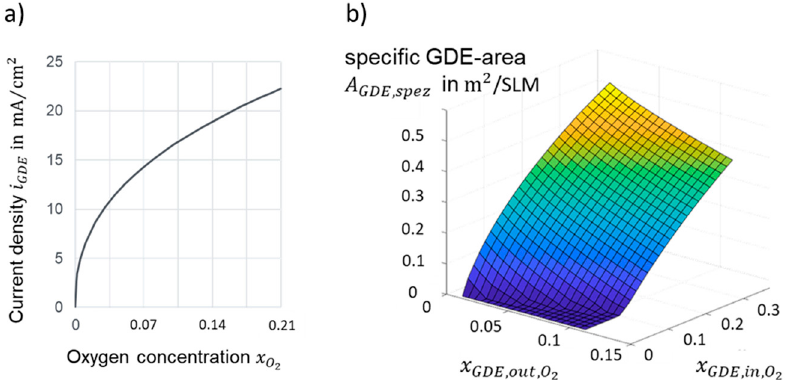
Figure 7. GDE modeling: ( a ) current density curve (fit function to experimental data), ( b ) map of speci fi c GDE-area.